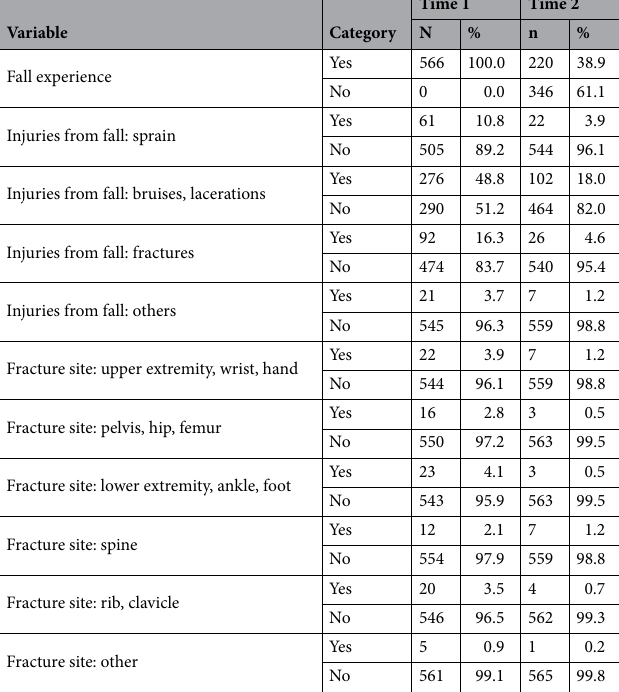
Table 2. Fall injury characteristics of participants (N =